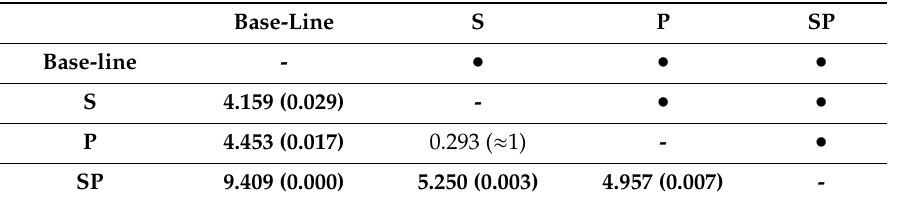
Table 2. One-way ANOVA results on 30 stimuli, post-hoc comparisons. The average difference (absolute value) and the associated probability are in parentheses. Statistically detectable differences are in bold.